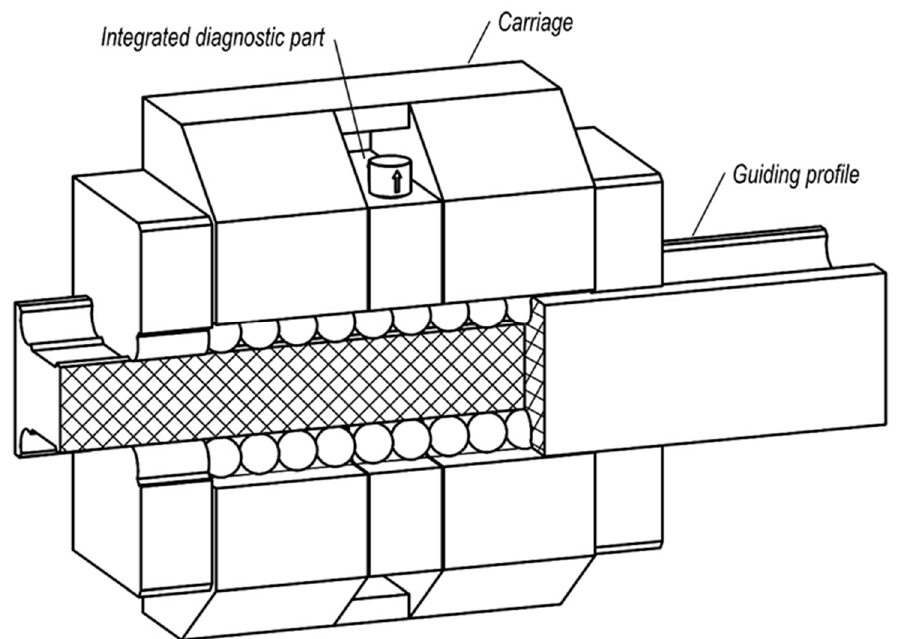
Figure 3. The linear system carriage with the integrated diagnostic part.